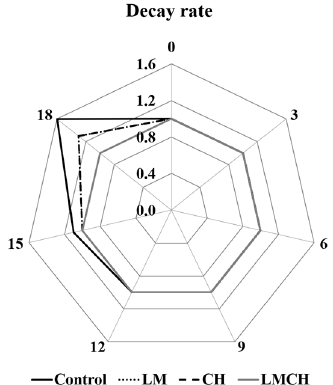
Figure 4. Decay rate of fresh-cut cantaloupe with and without an edible coating (control) during 18 days of storage at 4 °C.